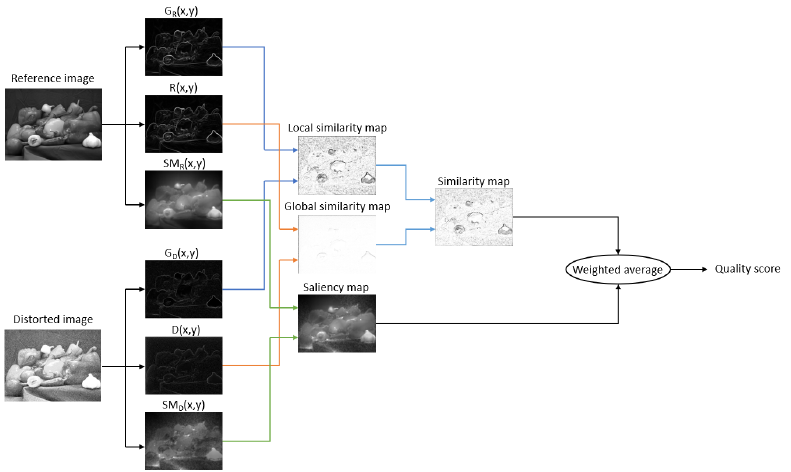
Figure 3. High-level overview of the proposed